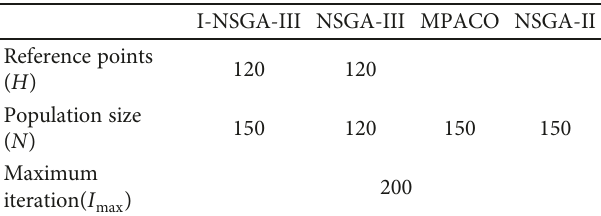
Table 14: Number of reference points, population size, and maximum number of iterations for all